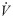
A is present inside the cell with a constant amount of nA moles, while the cellular volume V increases with rate V˙.